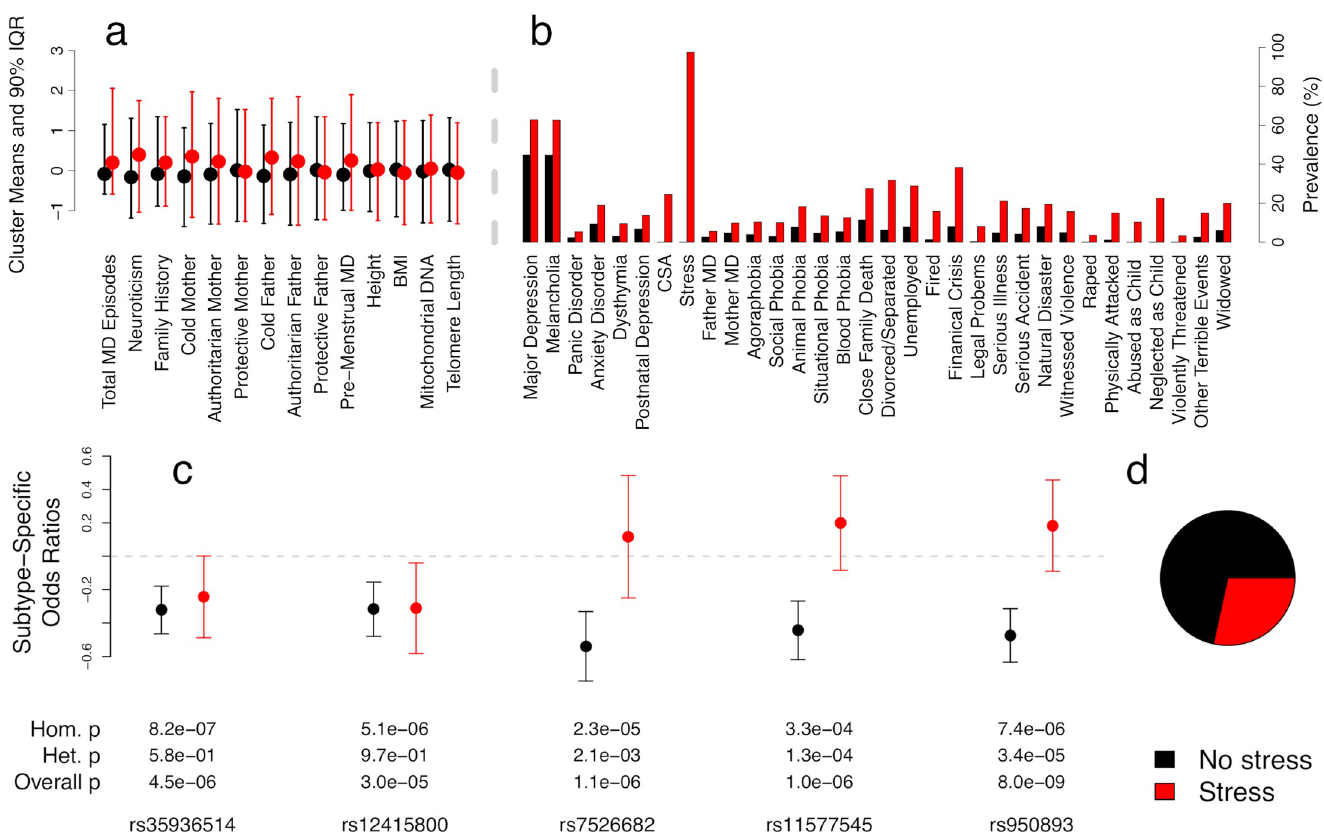
Fig 2. Genetic heterogeneity in the CONVERGE major depression dataset. Quantitative trait 90% inter-quantile ranges (a) and binary trait prevalences (b) are shown for each subtype. (c) Per-subtype odds ratios ( ± 2 s.e.) for two SNPs discovered by (homogeneous) GWAS [43] (left) and three SNPs discovered using known subtypes [44]